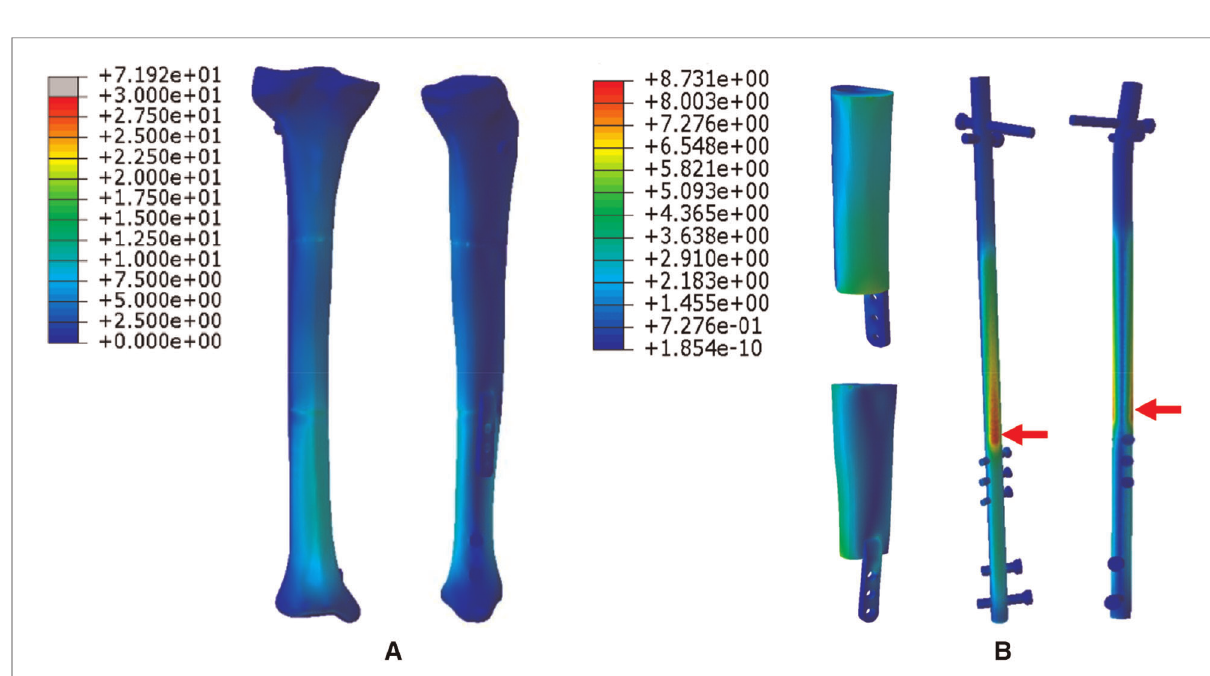
FIGURE 8 Von Mises stress distribution in Mode IV, the red arrows indicate the maximum stress concentration. ( A ) Stress distribution of the integral structure. ( B ) Stress distribution of the prosthesis and internal fi